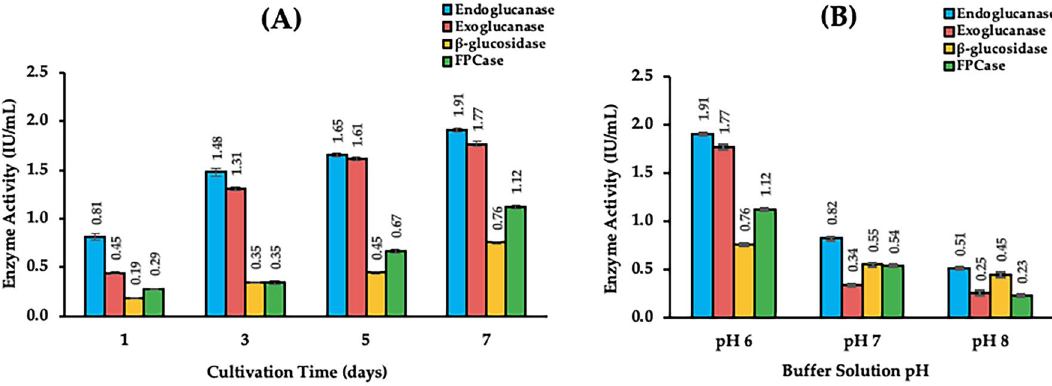
Figure 6. Cellulolytic enzyme activity of strain USB13 T . Enzyme activity was defined in international units (IU); one unit of enzymatic activity was defined as the amount of enzyme that releases 1 μmol of glucose per mL per 1 min of reaction. ( A ) cellulase activity results under different cultivation time; ( B ) cellulase activity under different buffer solution pH. Values in the figure are mean values of triplicate data with standard